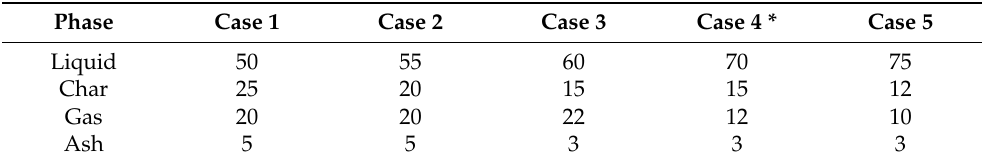
Table 7. Possible pyrolysis yields listed as cases.